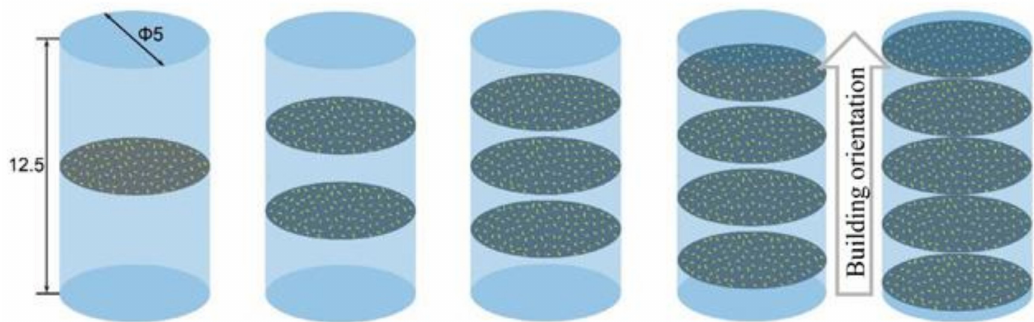
Figure 19. Specimens printed by PLA with one layer of SiCnw, two layers, three layers, four layers, and five layers with dimensions in millimeter (Reproduced with permission from Reference [164], copyright 2019,